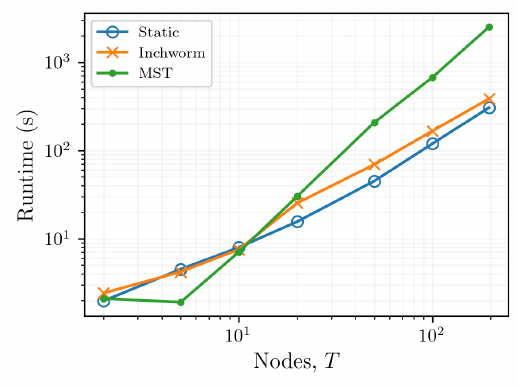
Figure 9. The computational efficiency of the static reference, inchworm, and MST reconstruc- tion